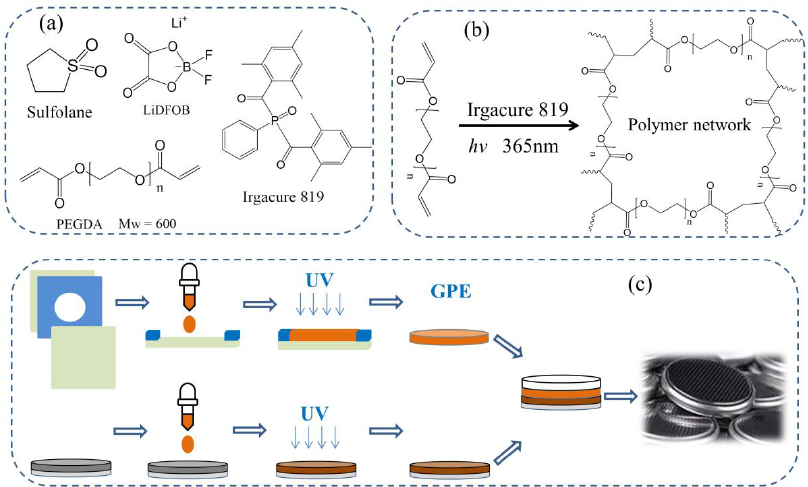
Figure 1. ( a ) Chemical structure of major chemicals; ( b ) Reaction mechanism and possible